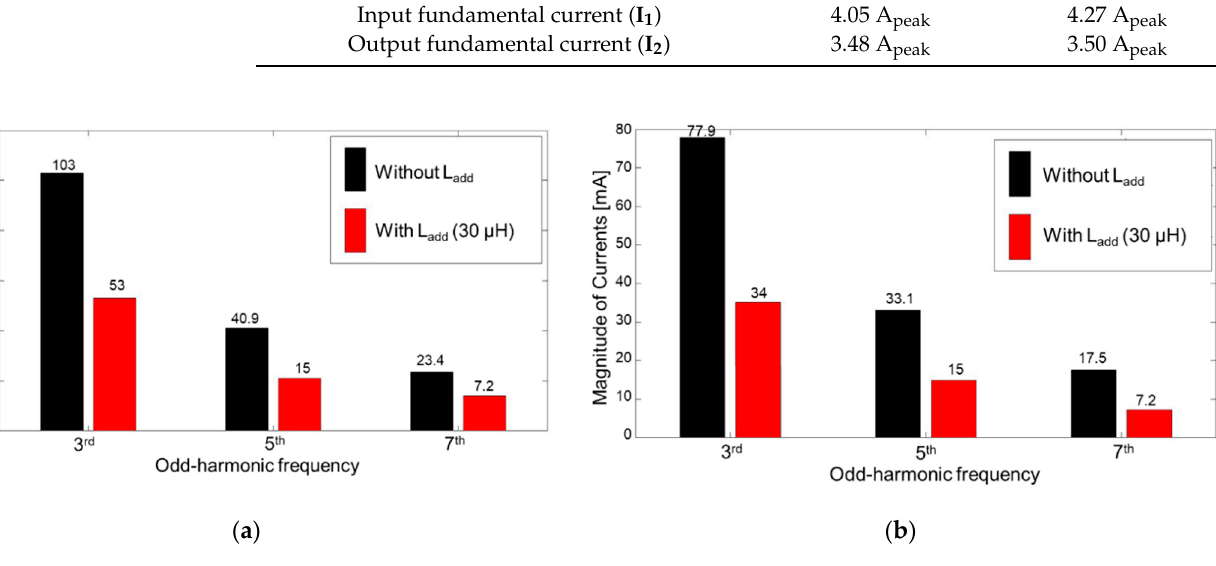
Figure 25. Measurement of the FFT of Tx and Rx current waveforms when operating a 30 W class WPT according to the presence of Ladd (30 μH ): ( a ) comparison of odd harmonic components of Tx current ( I 1 ); ( b ) comparison of odd harmonic components of Rx current ( I 2 ). Table 14. Measurement results of the Tx and Rx fundamental current components when operating a 30 W class WPT according to the presence of Ladd (30 μH ).